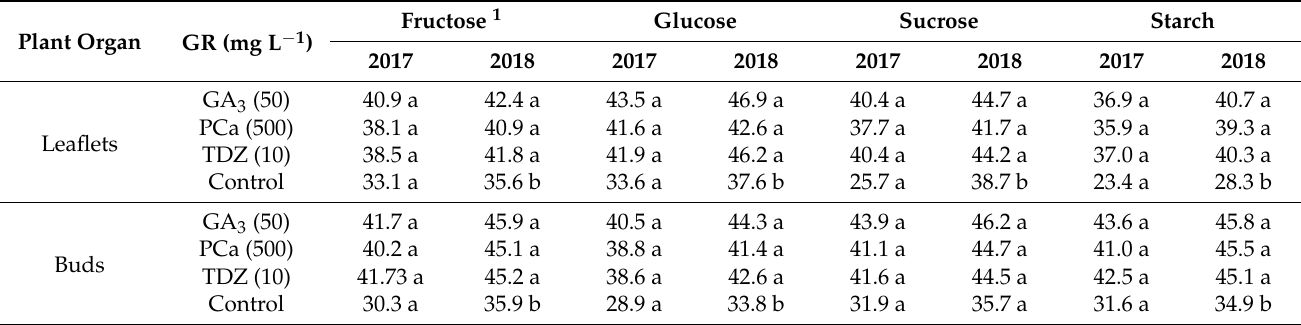
Table 1. Concentration of NSC in cv. Wichita pecan leaflets and buds treated with GR.